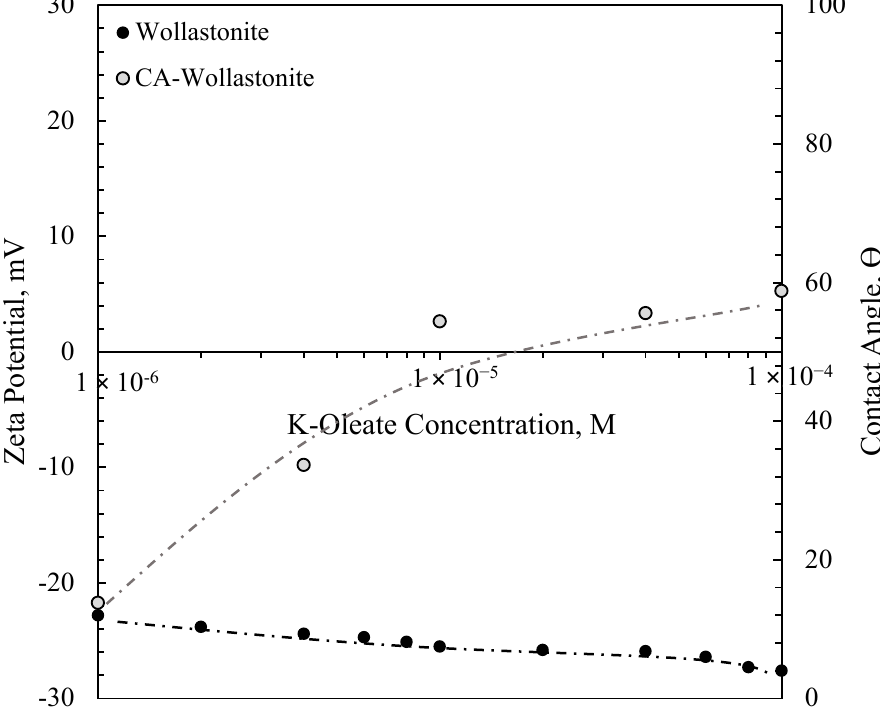
Figure 9. Combined presentation of contact angle and zeta potential measurements for calcite.